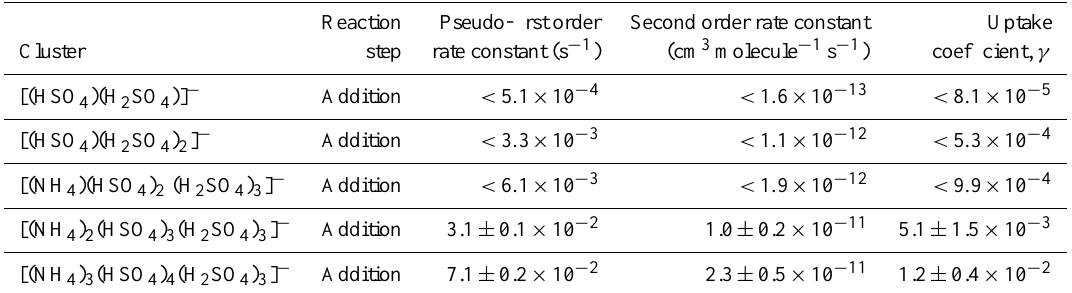
Table 2. Pseudo-first order rate constants, second order rate constants, and uptake coefficients for reaction of ammonia with negatively- charged ammonium bisulfate clusters ∗